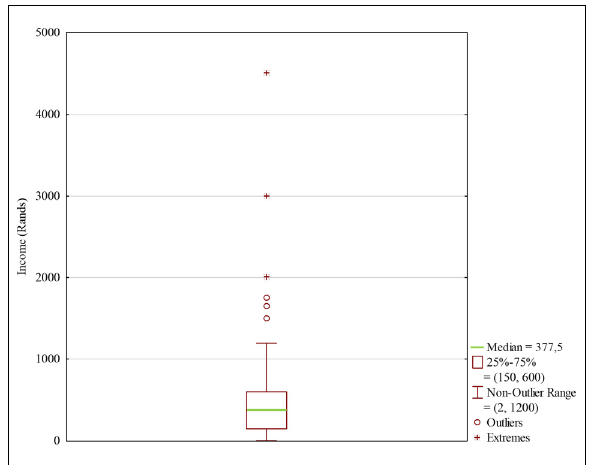
Average self-declared weekly incomes from e-waste collection.